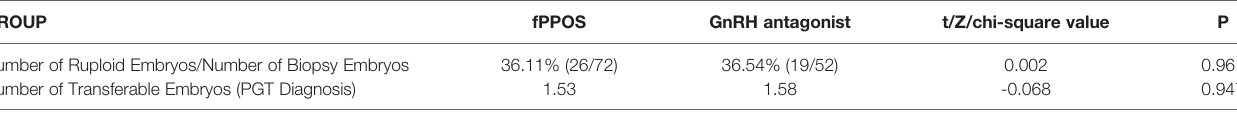
TABLE 5 | Data of patients who performed PGT technology. GROUP fPPOS Number of Ruploid Embryos/Number of Biopsy Embryos